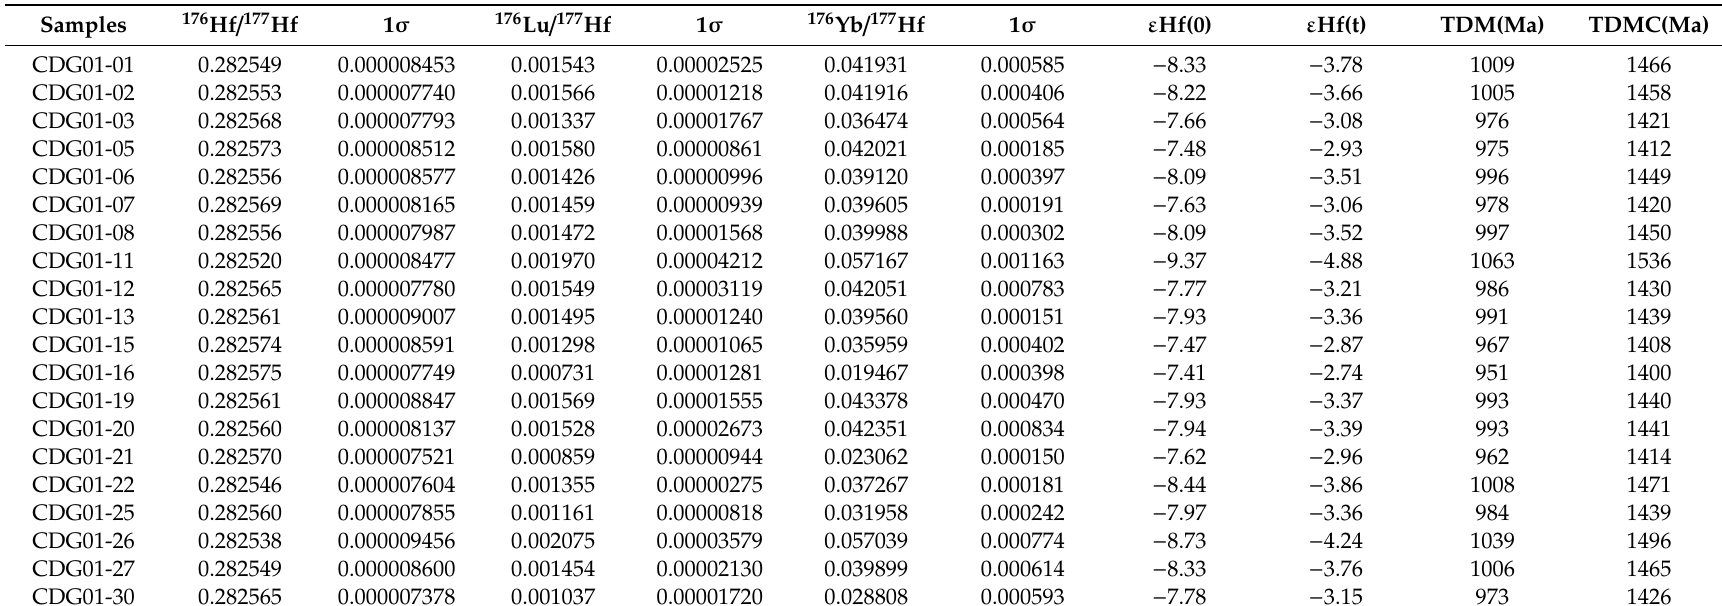
Table 3. Hf isotopes in zircon grains from Changdagou granodiorite